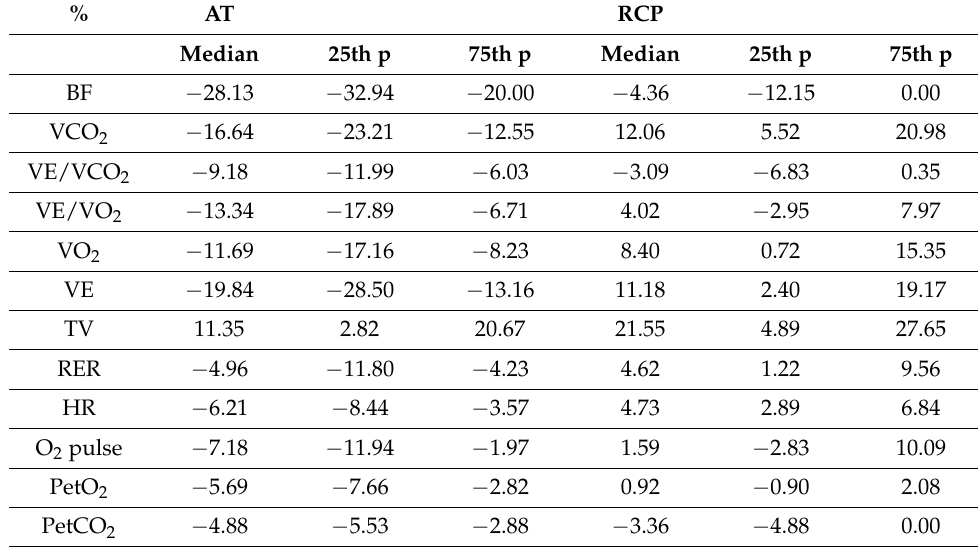
Table 4. Relative changes between CPET parameters from CPET2 (run with vAT with +12 kg weight vest) and CPET1 (AT, RCP). %